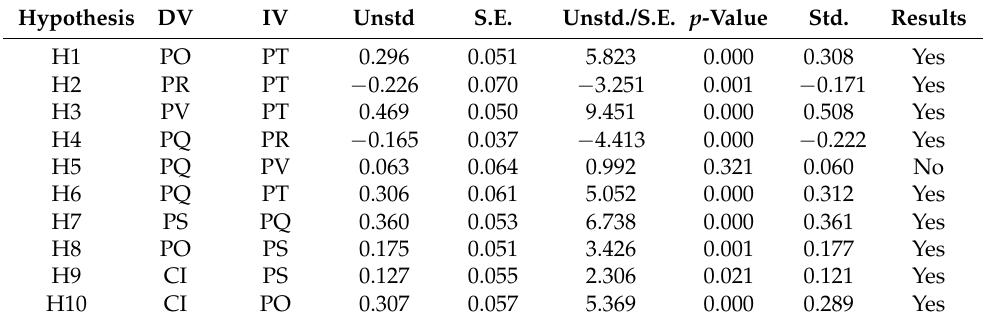
Table 7. Regression